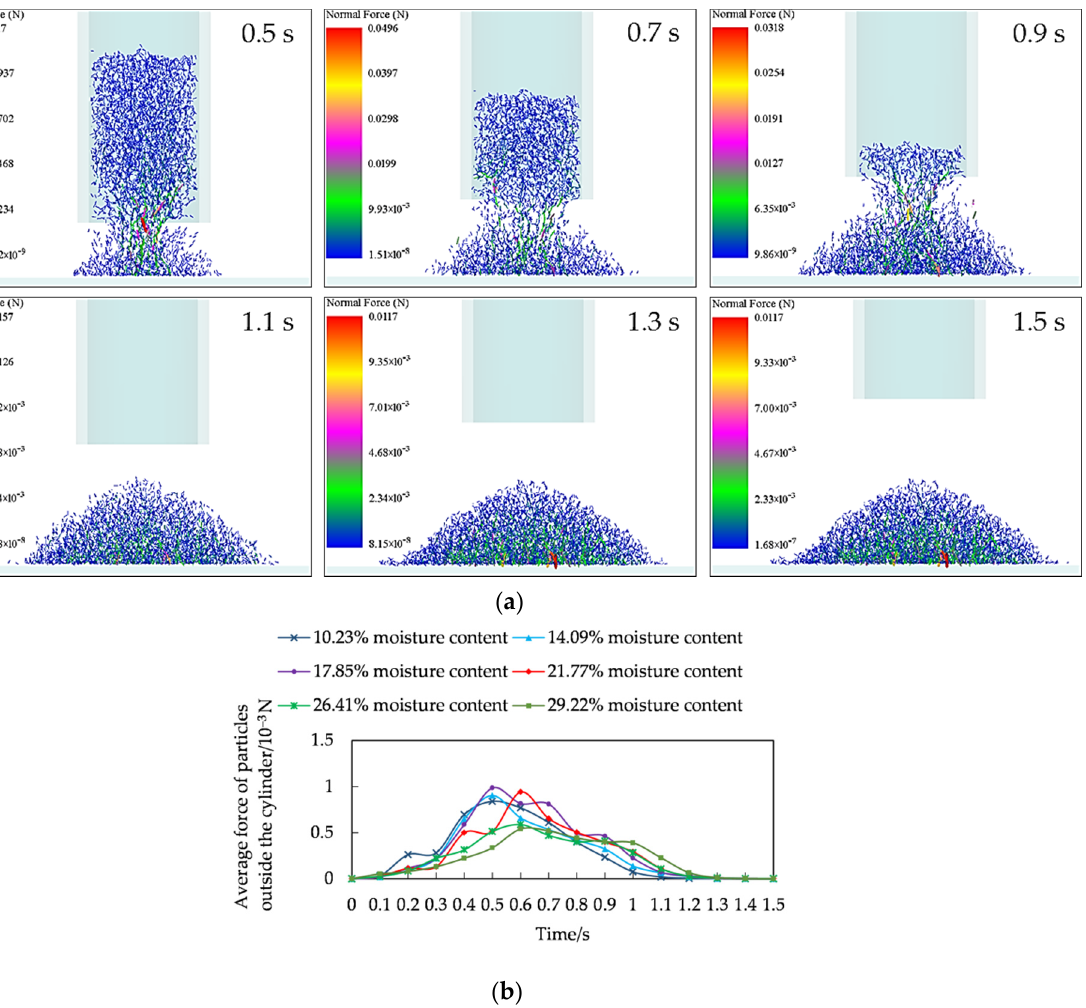
Figure 3. Force of rice seeds accumulation with 29.22% moisture content: ( a ) force distribution; ( b ) average force of the rice seeds outside the cylinder at different moments.